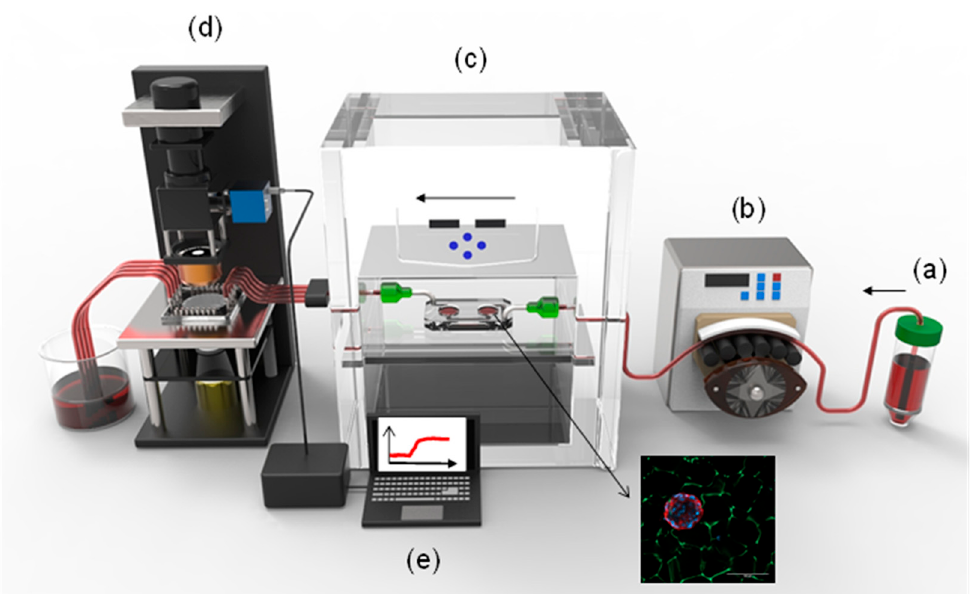
Figure 1. Schematic overview of the integration of the islet-on-a-chip (IOC) device with the on-chip LSPR sensing platform. ( a ) KRBH buffer with a chosen glucose content; ( b ) a peristaltic pump to drive the buffer into the IOC device; ( c ) IOC device containing mouse islets embedded in a cellulose-based scaffold; ( d ) the LSPR sensing platform to interrogate the buffer from the IOC device; and ( e ) monitoring of the insulin detection as a consequence of glucose stimulation.